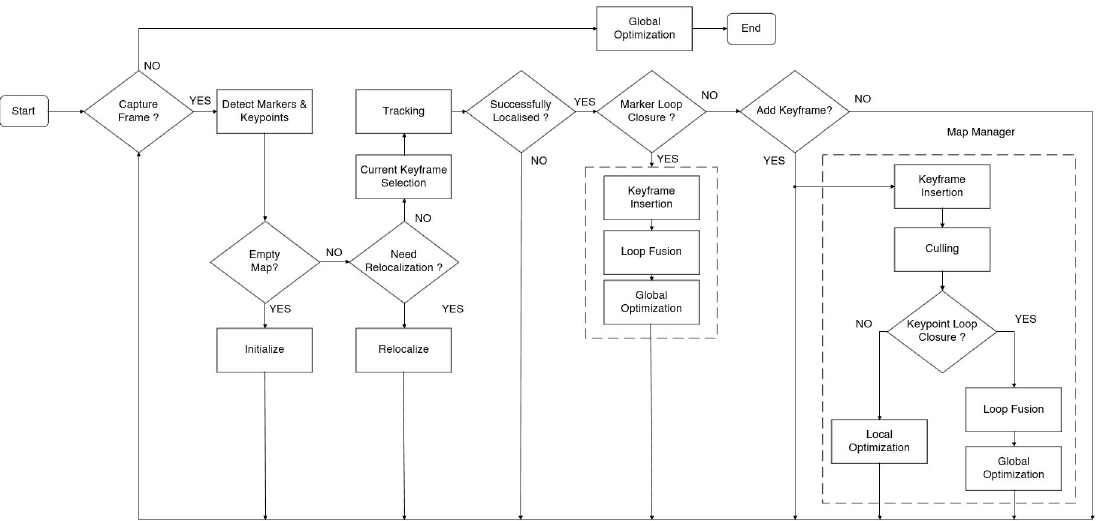
Figure 2. UcoSLAM architecture